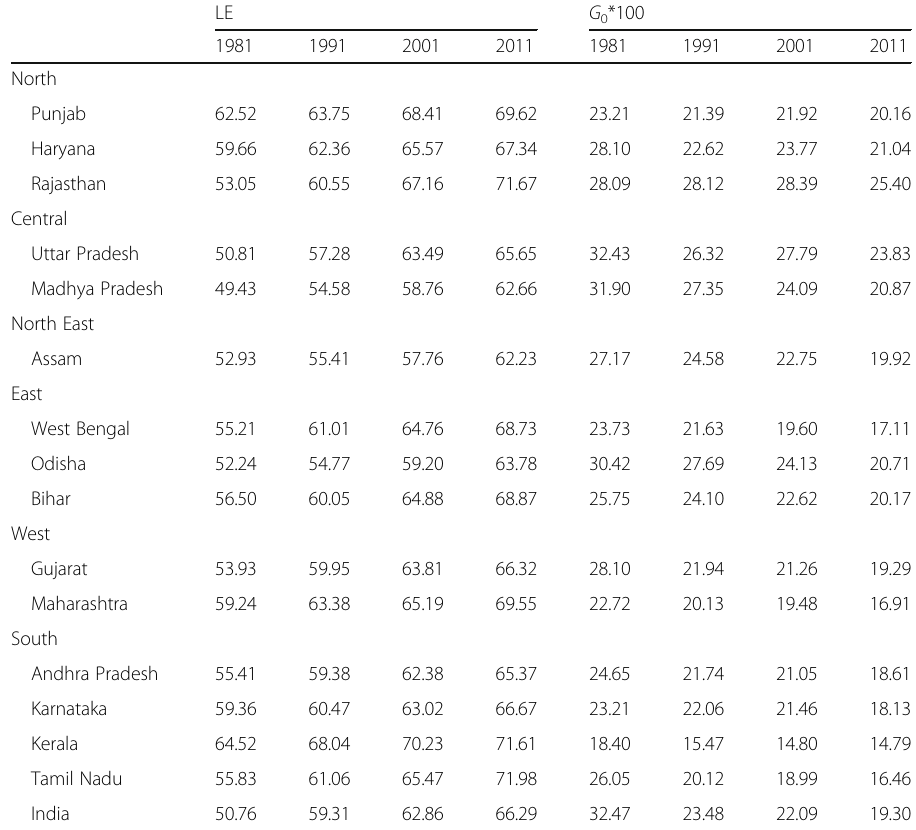
Table 1 Life expectancy (LE) at birth and Gini coefficient of LE from 1981 to 2011, India and major states,